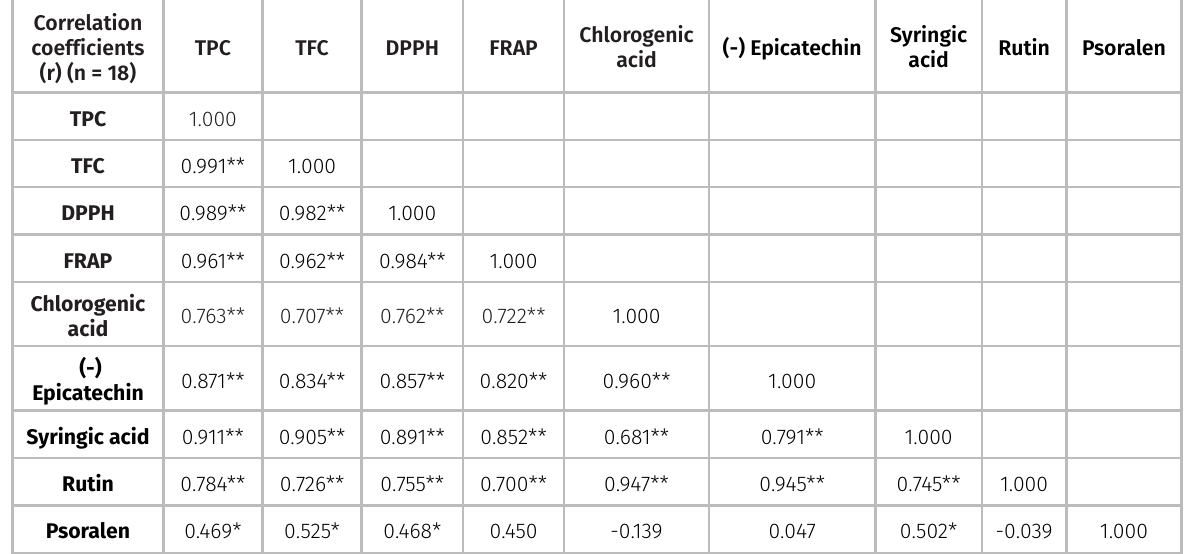
Table III. Correlation among TPC, TFC, DPPH, FRAP and individual polyphenols of extracts from fig seeds. Correlation